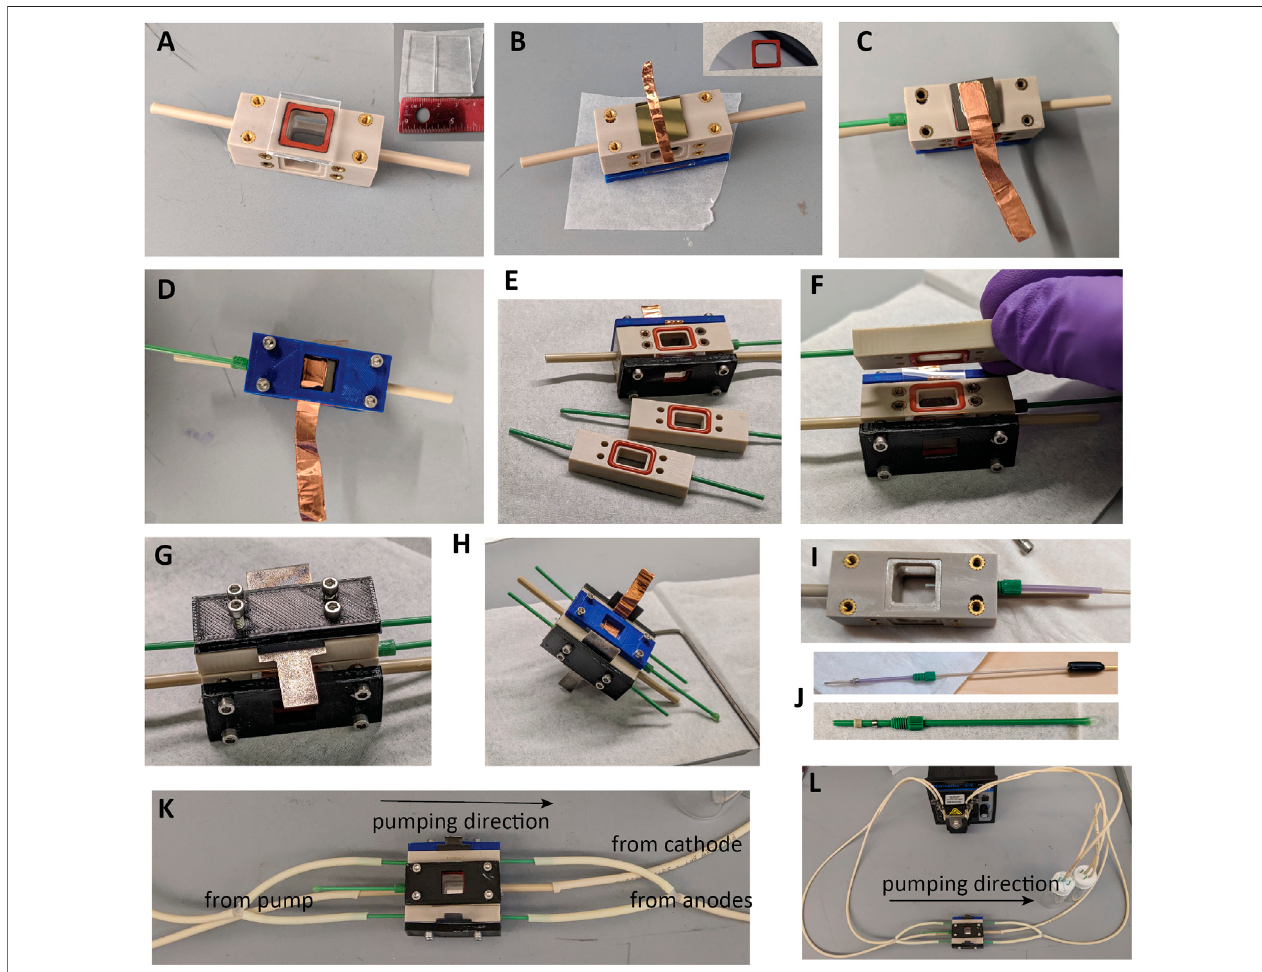
FIGURE 6 | Assembly of the testing vessel. (A) Placing window. (B) Placing a placing a photoelectrode with integrated ohmic contact and folded copper tape for theconnector. (C) PhotoelectrodewithohmiccontactaddedusingInGaeutectic,silverepoxy,andcoppertape. (D) CompressionplateaddedtoWE. (E) O-ringsadded to anode chambers. (F) Na fi on added. (G) Anode chamberadded. (H) Assembled withone anode compartment. (I) Depth forreferenceelectrodein thecell. (J) REand sham assembly. (K) Tubing connections and fl ow direction. (L) Pump, testing vessel, and